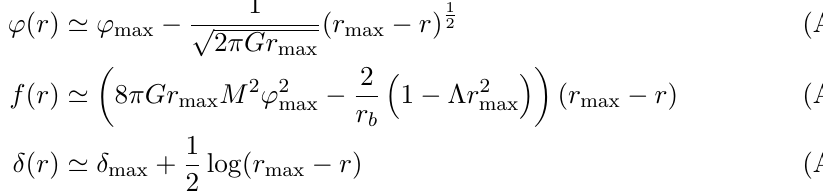
Figure 27 . Contour plot on r c − ϕ 0 plane. The height represents the value of J ϕ ( r b = 5 √ − 0 . 04 /G, M = 0 . 1 / G